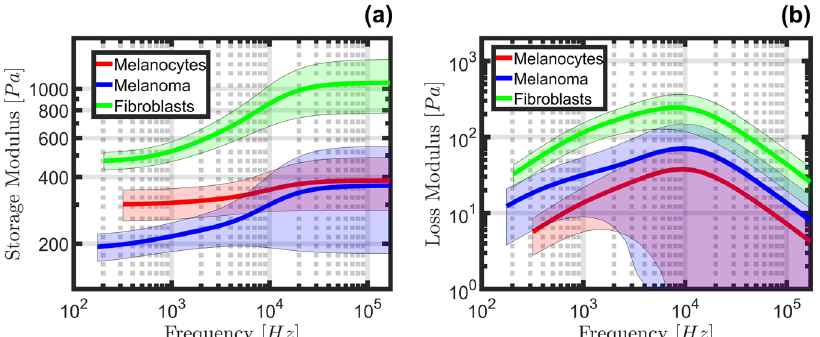
Fig. 4 Viscoelastic harmonic quantities acquired from 2D adherent normal and cancerous skin cells. The Storage ( a ) and Loss ( b ) modulus have been calculated from the parameterized Generalized Maxwell model for 2D adherent normal and cancerous human skin cells. These viscoelastic harmonic quantities are calculated using the optimal parameter set obtained from analyzing an average of 70, 71, and 193 force curves from the melanoma, melanocyte, and fi broblast cell conditions, respectively. In total, the averaged datasets contain curves collected from 13 unique melanoma cells, 12 unique melanocytes, and 33 unique fi broblasts. Note that the number of terms in the fi tted viscoelastic model series determines the number of distinct features present in the plots. The observed con fi dence intervals are shaded in matching colors for each model; the method for determining these bounds is outlined in the “ Methods ” section, and is based on the optimal parameter sets obtained using every individual curve from each cell